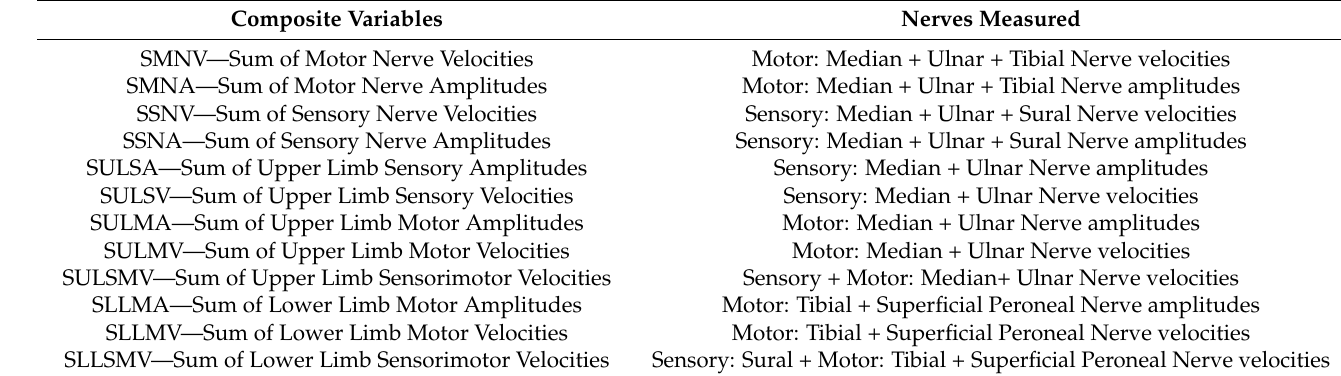
Table 1. List of composite dependent